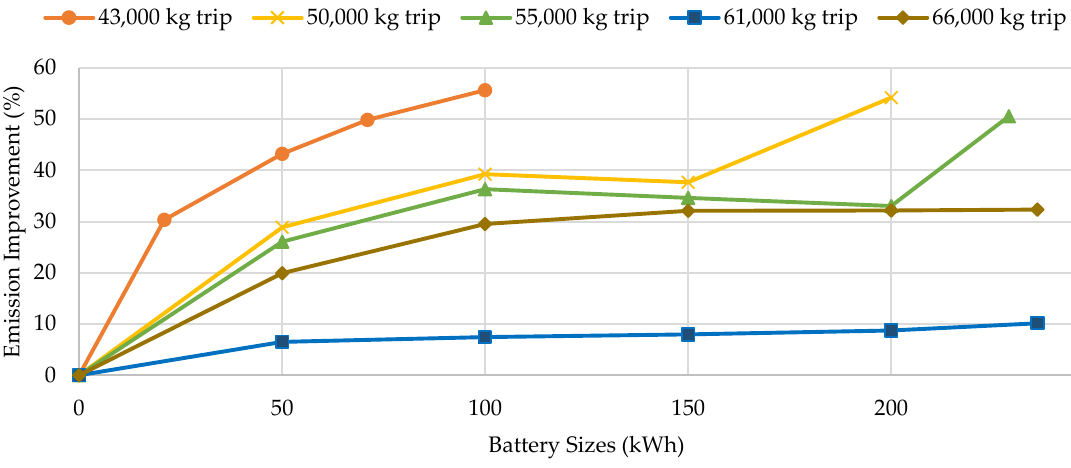
Figure 18. Total emission reduction in NSW (0.79 kg CO 2-e/ kWh).